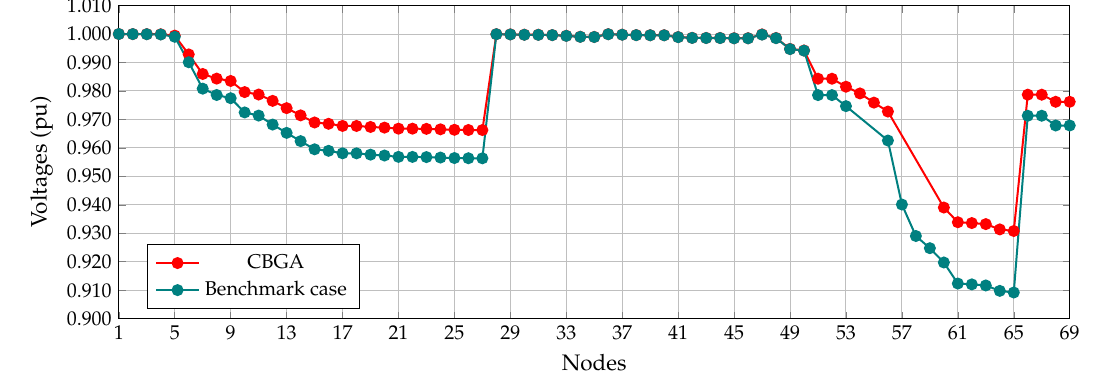
Figure 15. Voltage profiles in the 69-node test